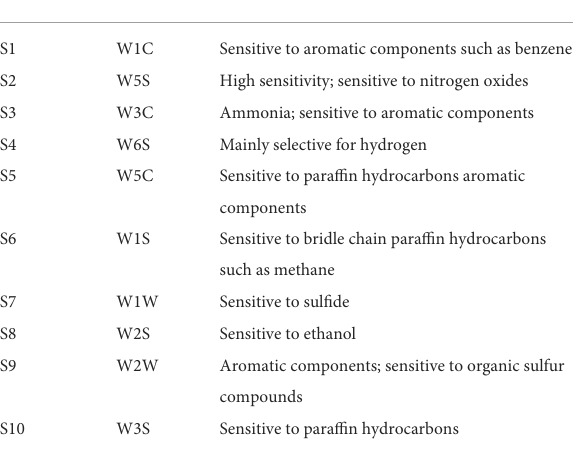
TABLE 1 Sensors used and their main application in